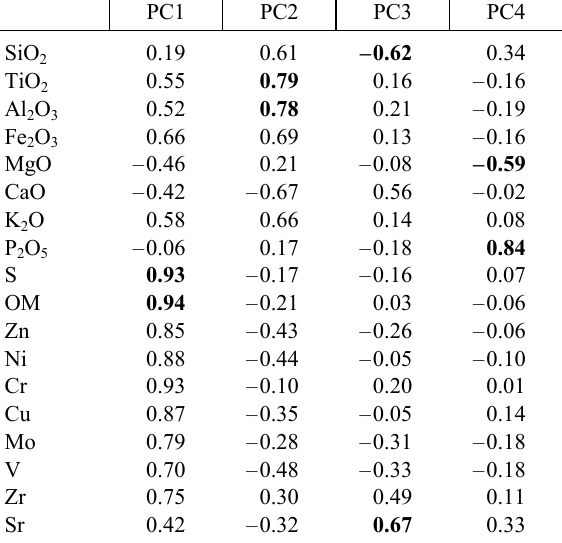
Table 2. Correlation between principal components and variables. The first two variables contributing the most to the construction of the corresponding component are in